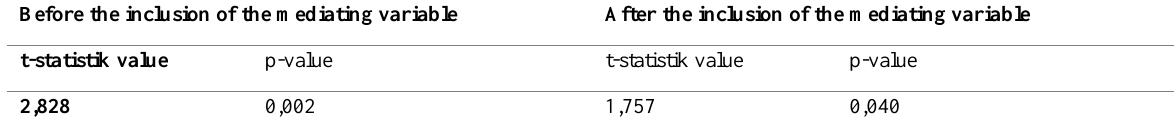
Table 4 : Comparison of t-statistic values before and after the inclusion of the mediating variable Before the inclusion of the mediating